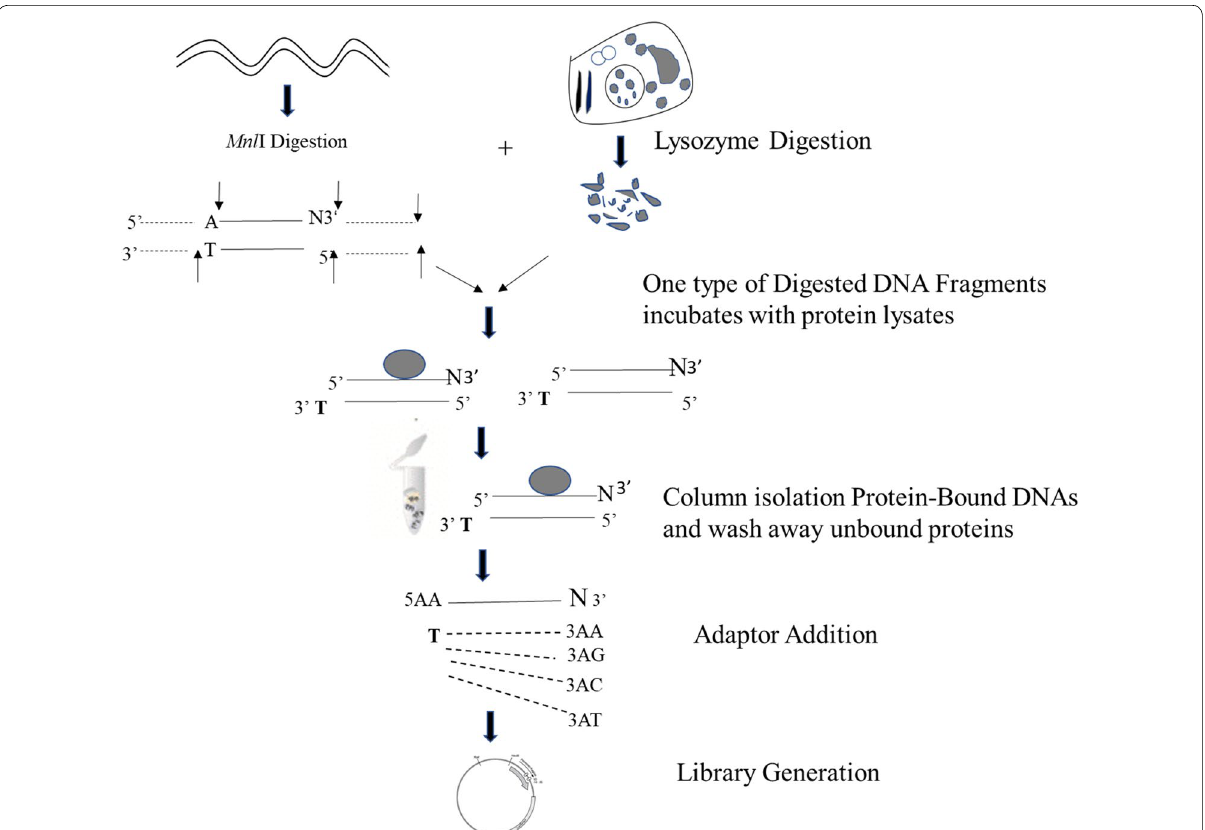
Fig. 1 a Schematic diagram of separation of protein-binding genomic DNA fragments for library construction. Genomic DNA was prepared from DH5α with proteinase K digestion followed by phenol and chloroform extraction. It was then sheared with Mnl I digestion. Proteins were also extracted from DH5α cells and incubated with the genomic DNA fragments to allow formation of protein/DNA complexes, which were able to retain on a filter column and to separate from the unbound DNA by the following washing steps. The protein-bound DNA fragments were then eluted and used for construction of libraries. b 8 different adaptors were made, AA5, AG5, AC5, and AT5, for ligating to 5 ′ end of Mnl I fragments, and AA3, AG3, AC3, and AT3 for ligation to 3 ′ terminus of Mnl I